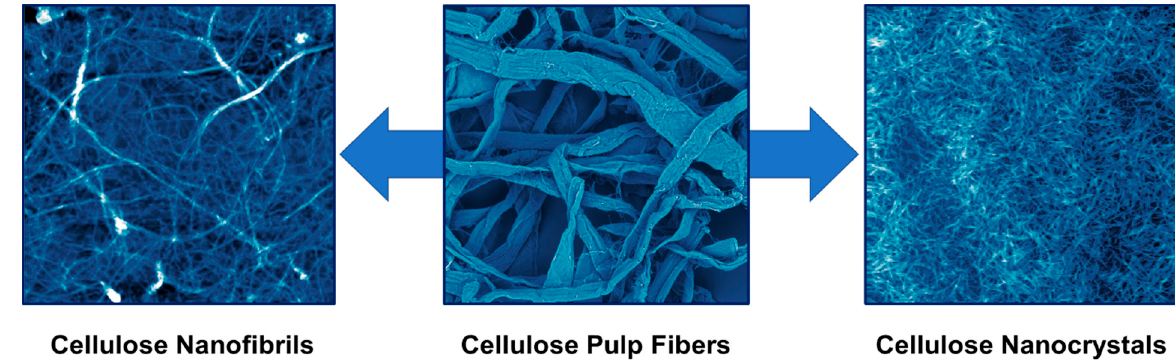
Figure 1. From cellulose pulp fibers to CNFs and CNCs. The photo of the cellulose pulp fibers was obtained using a scanning electron microscope (500 × 500 µm), while those of CNFs and CNCs are atomic force microscopy images (5 × 5 µm).